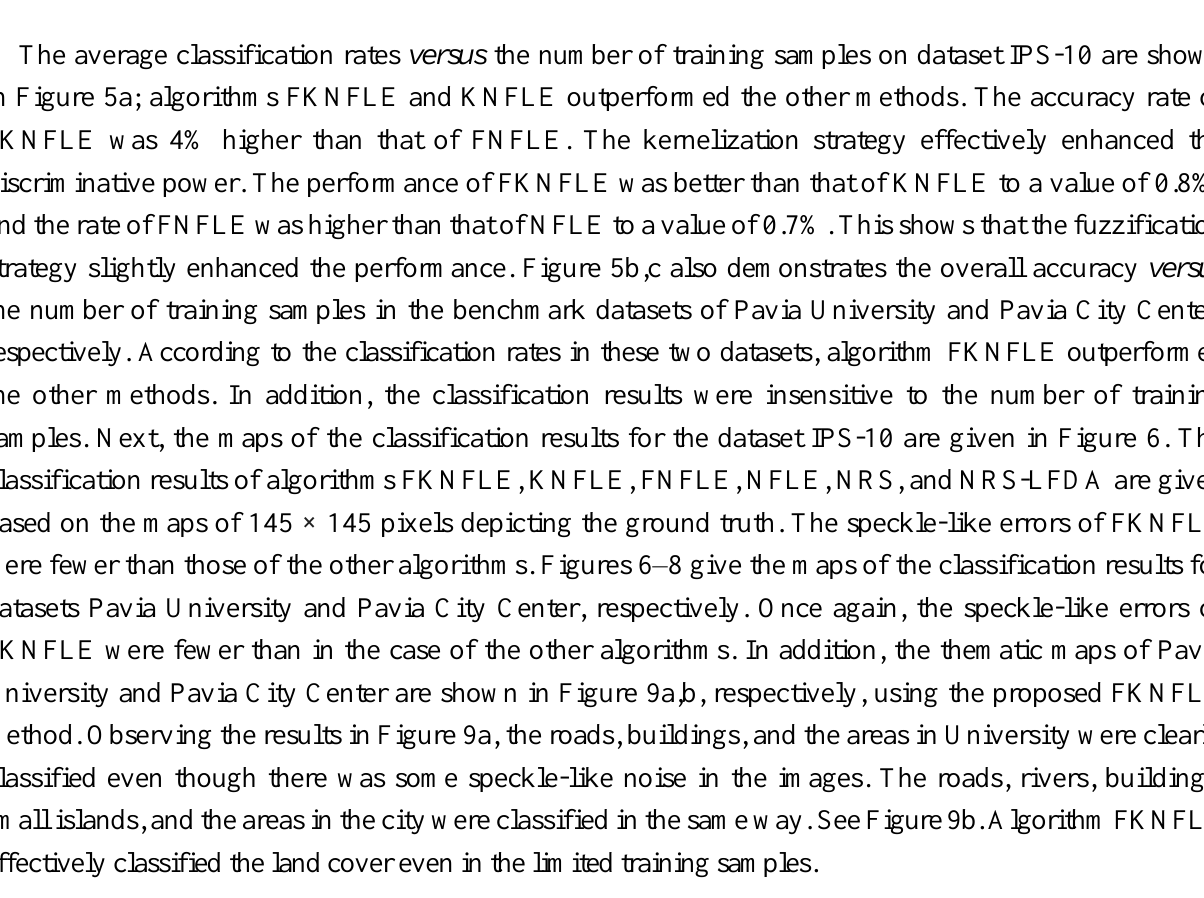
Figure 4. The classification accuracy versus the reduced dimension on three benchmark datasets using the various algorithms: ( a ) IPS-10; ( b ) Pavia University; ( c ) Pavia City